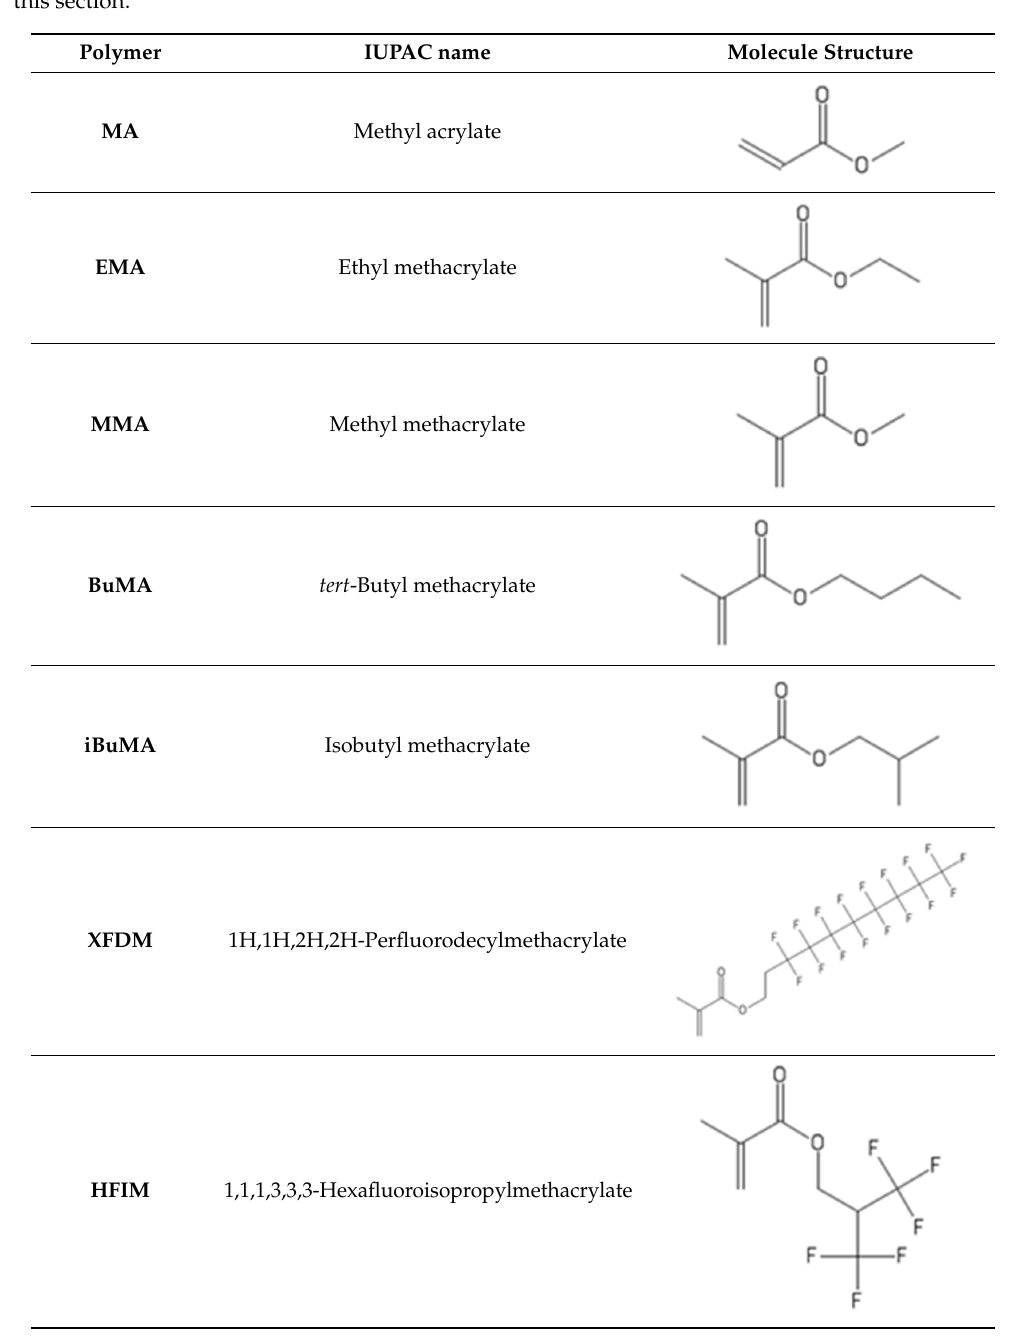
Table 7. Principal starting monomers used for the fabrication of the polymer coatings treated in this section.